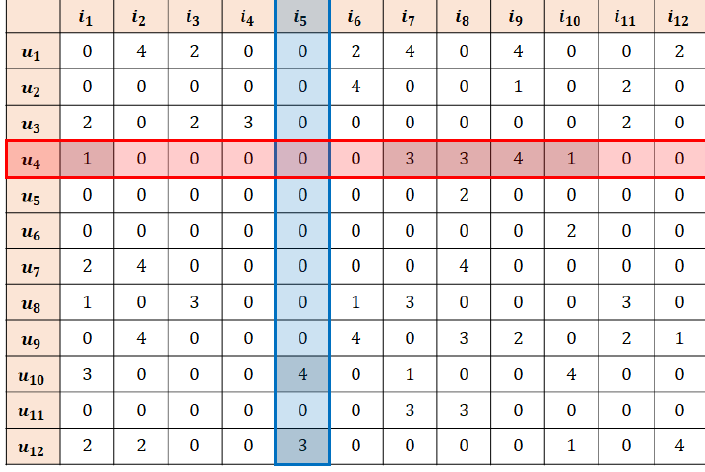
Figure 4. An example of missing data imputation of k-RRI (step 2).